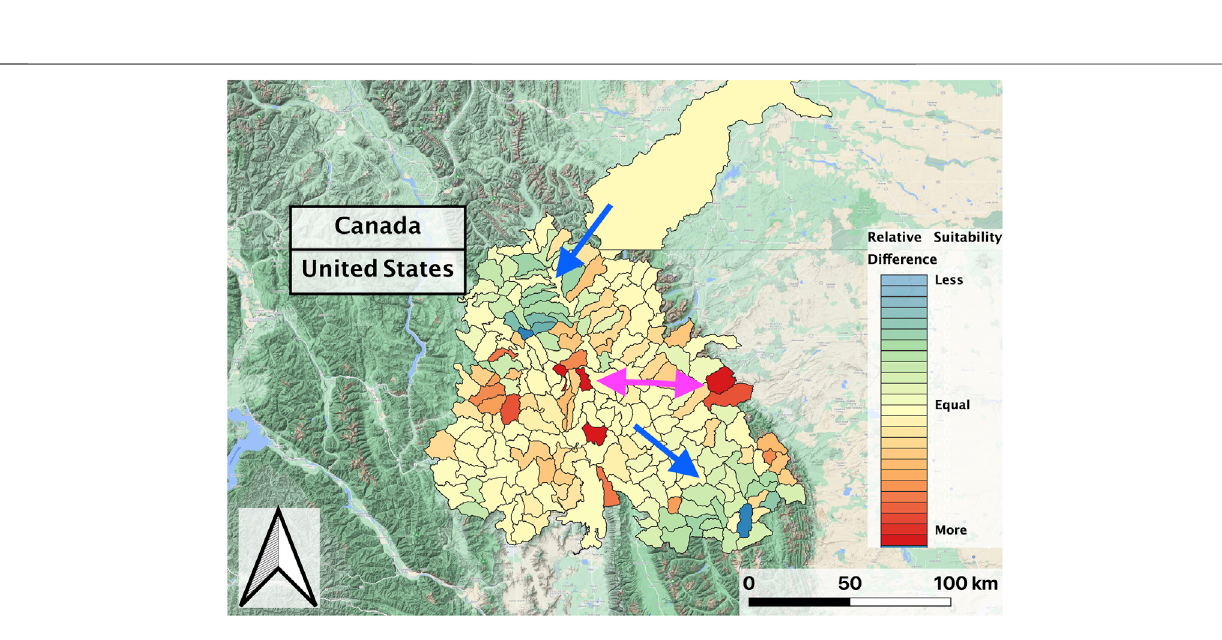
Frontiers in Big Data |